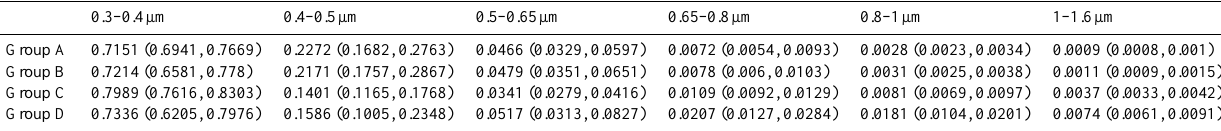
Table 8. Posterior credibility intervals of alr − 1 ( γ ) , i.e. the estimated average size distribution.